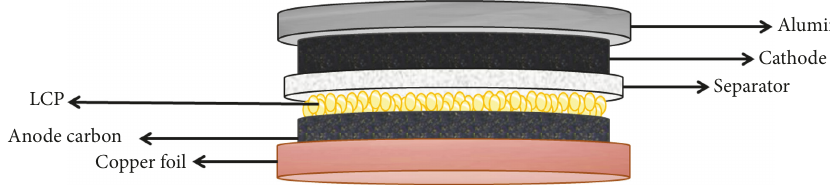
Figure 1: Schematic of coin cell assembly.